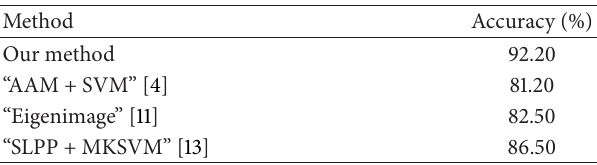
Table 2: Comparison of different reported results on pain